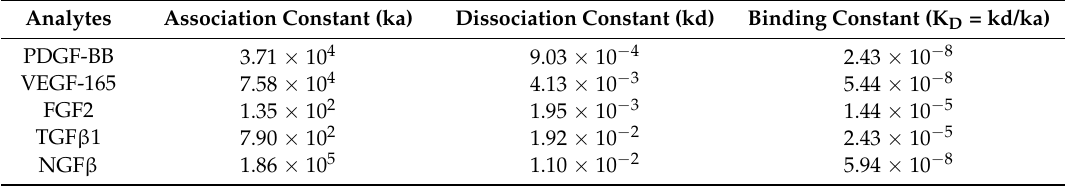
Table 1. Summary of analyte binding to